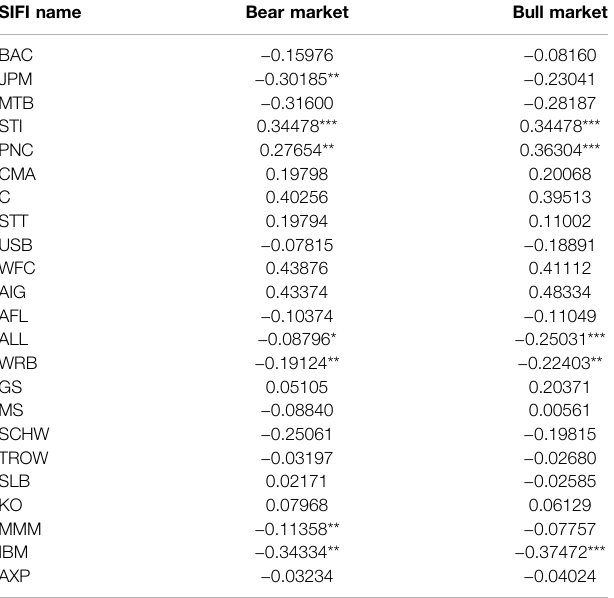
TABLE 6 | Network in fl uences of the 23 US SIFIs based on TENQR model ( τ = 0.99). SIFI